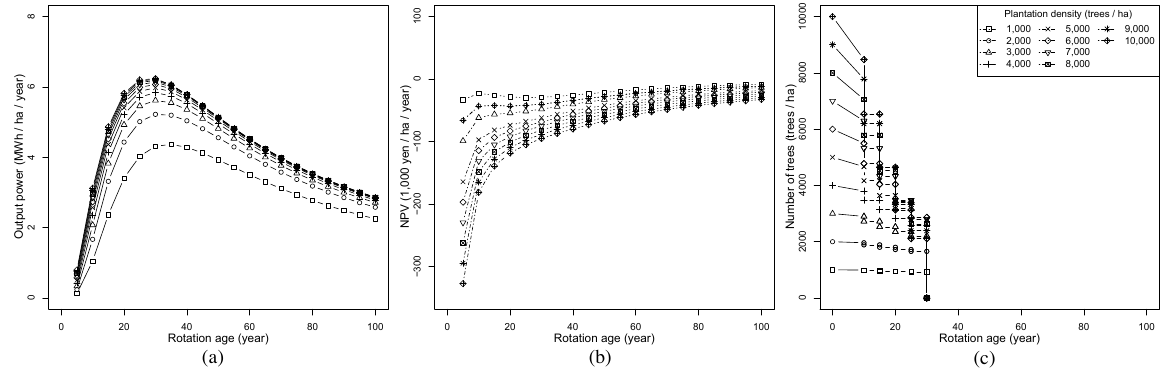
Figure 1. The electric output power ( a ) and net present value (NPV) ( b ) when wood chip production was maximized, and the optimal thinning regime for the rotation age of 30 years ( c ). The legend of the plantation density is shown in the figure ( a